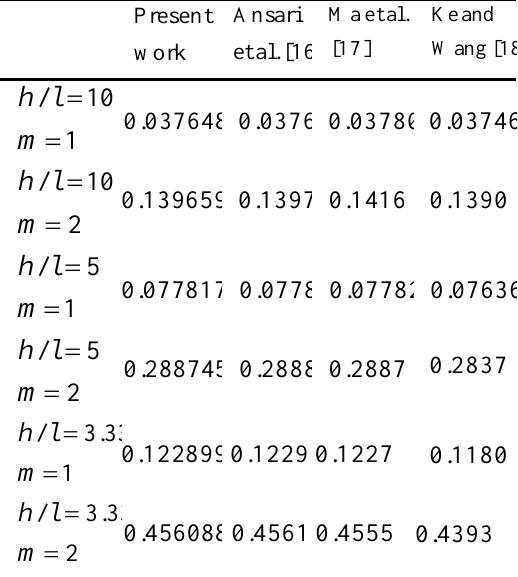
Table 2. Comparison of first two natural frequencies (MHz) for isotropic homogeneous Timoshenko micro- beam model